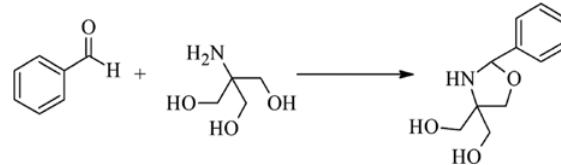
Figure 2: Chemical reaction between tris(hydroxymethyl)ami- nomethane (TRIS) and benzaldehyde